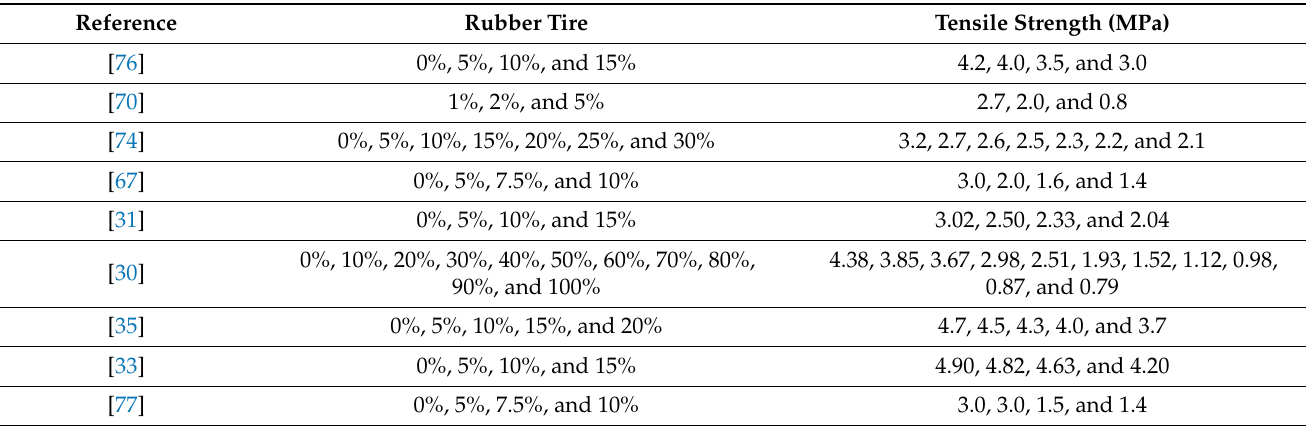
Table 3. Summary of tensile strength